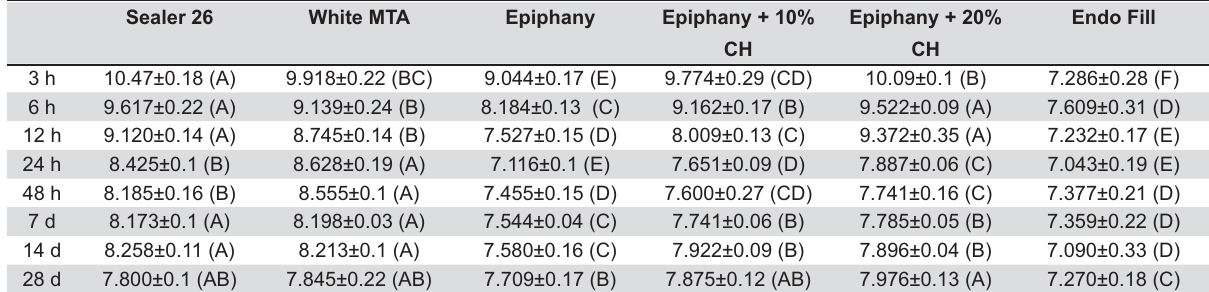
Table 1- Mean ± standard deviation of hydroxide ions (pH) released from the materials studied after different periods of time